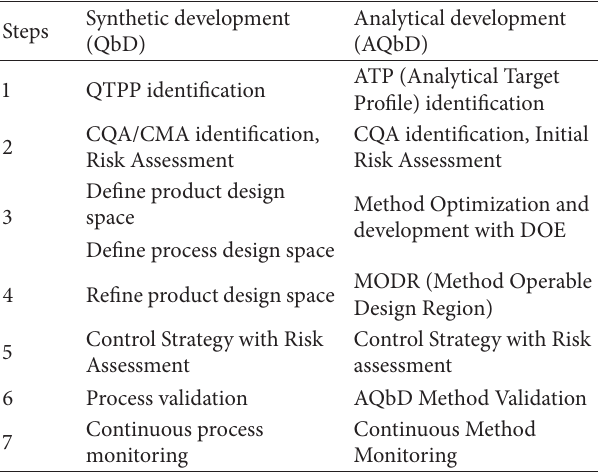
Table 1: QbD tools for synthetic development and analytical devel-